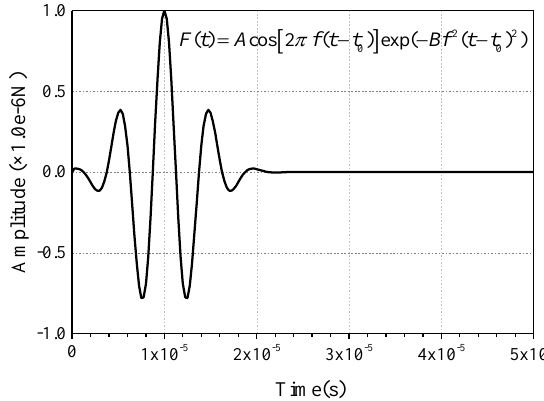
Figure 6. The cosine wavelet voltage signals (200 kHz).